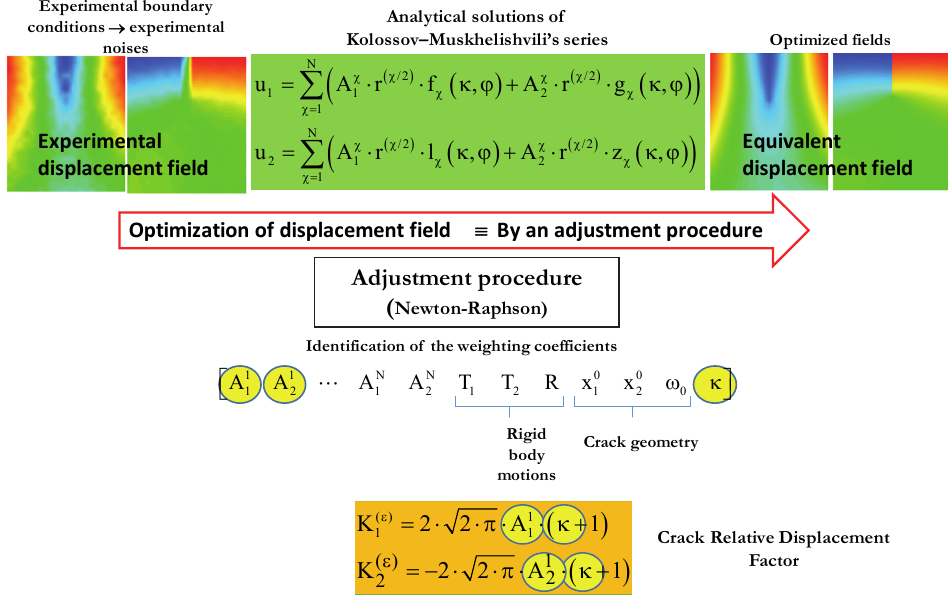
Figure 7: Methodology of CRDF